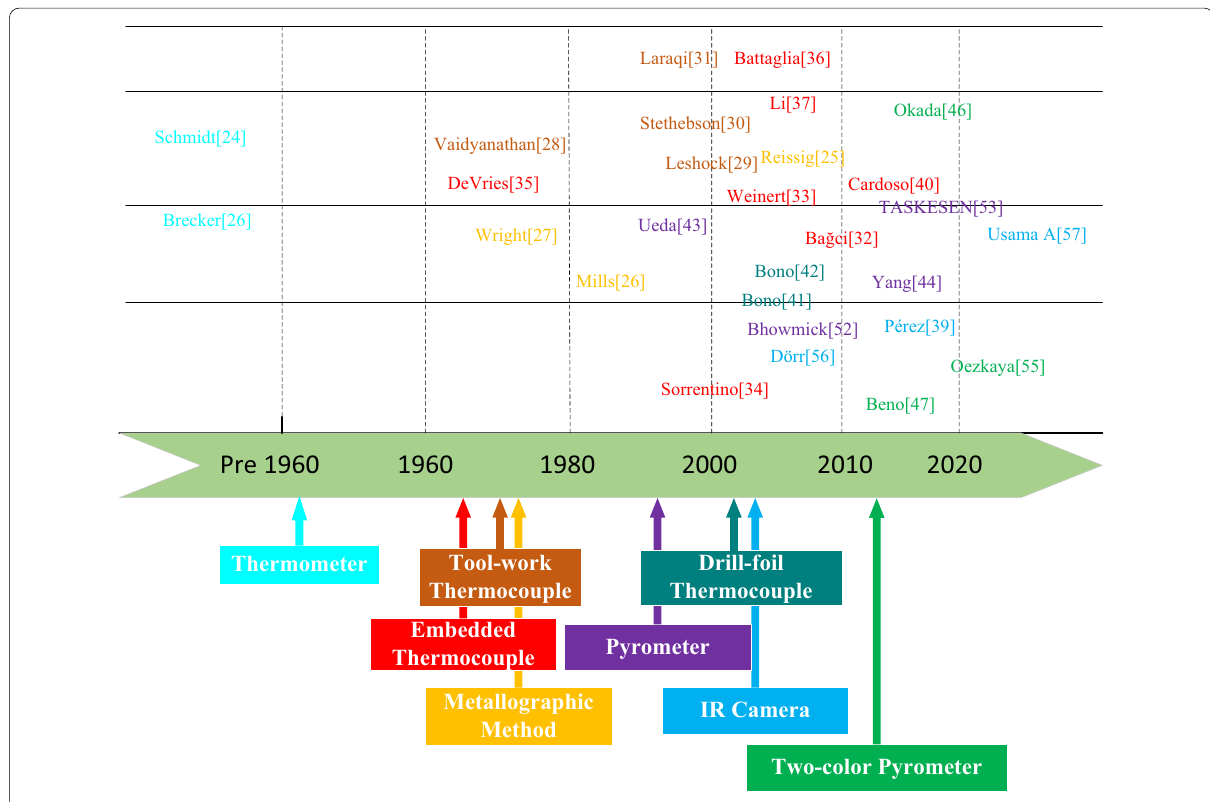
Figure 4 The development of different techniques for temperature